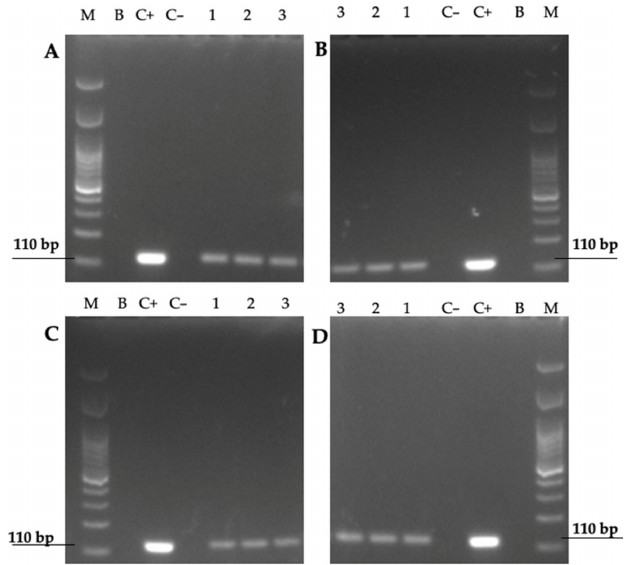
Figure 9. Images of 2% agarose gel showing the amplicons resulting from the amplification, by PCR, of the 16S rRNA gene of H. pylori from the total DNA of different Candida strains previously co-cultured under different oxygen concentrations with H. pylori J99 strain: ( A ) H. pylori J99 strain and C. albicans ATCC 90028 strain co-culture; ( B ) H. pylori J99 strain and C. glabrata ATCC 90030 strain co-culture; ( C ) H. pylori J99 strain and C. albicans VT-3 strain co-culture; ( D ) H. pylori J99 strain and C. glabrata LEO-37 strain co-culture. M, markers of molecular weight; B, blank (master mix, primers, and PCR grade water); C − , negative control (pure C. glabrata LEO ‐ 37 strain DNA); C+, positive control (pure H. pylori J99 strain DNA). Lanes 1, 2 and 3: amplicons amplified from the total DNA extracted from yeast cells previously co ‐ cultured with H. pylori under aerobic, microaerobic, or anaerobic conditions, respectively.